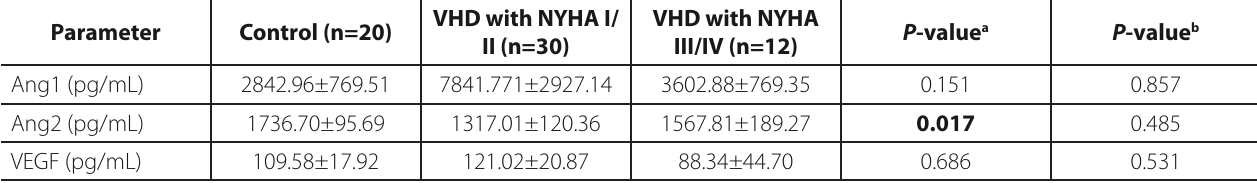
Table 3. Ang1, Ang2, and VEGF levels in control group and VHD